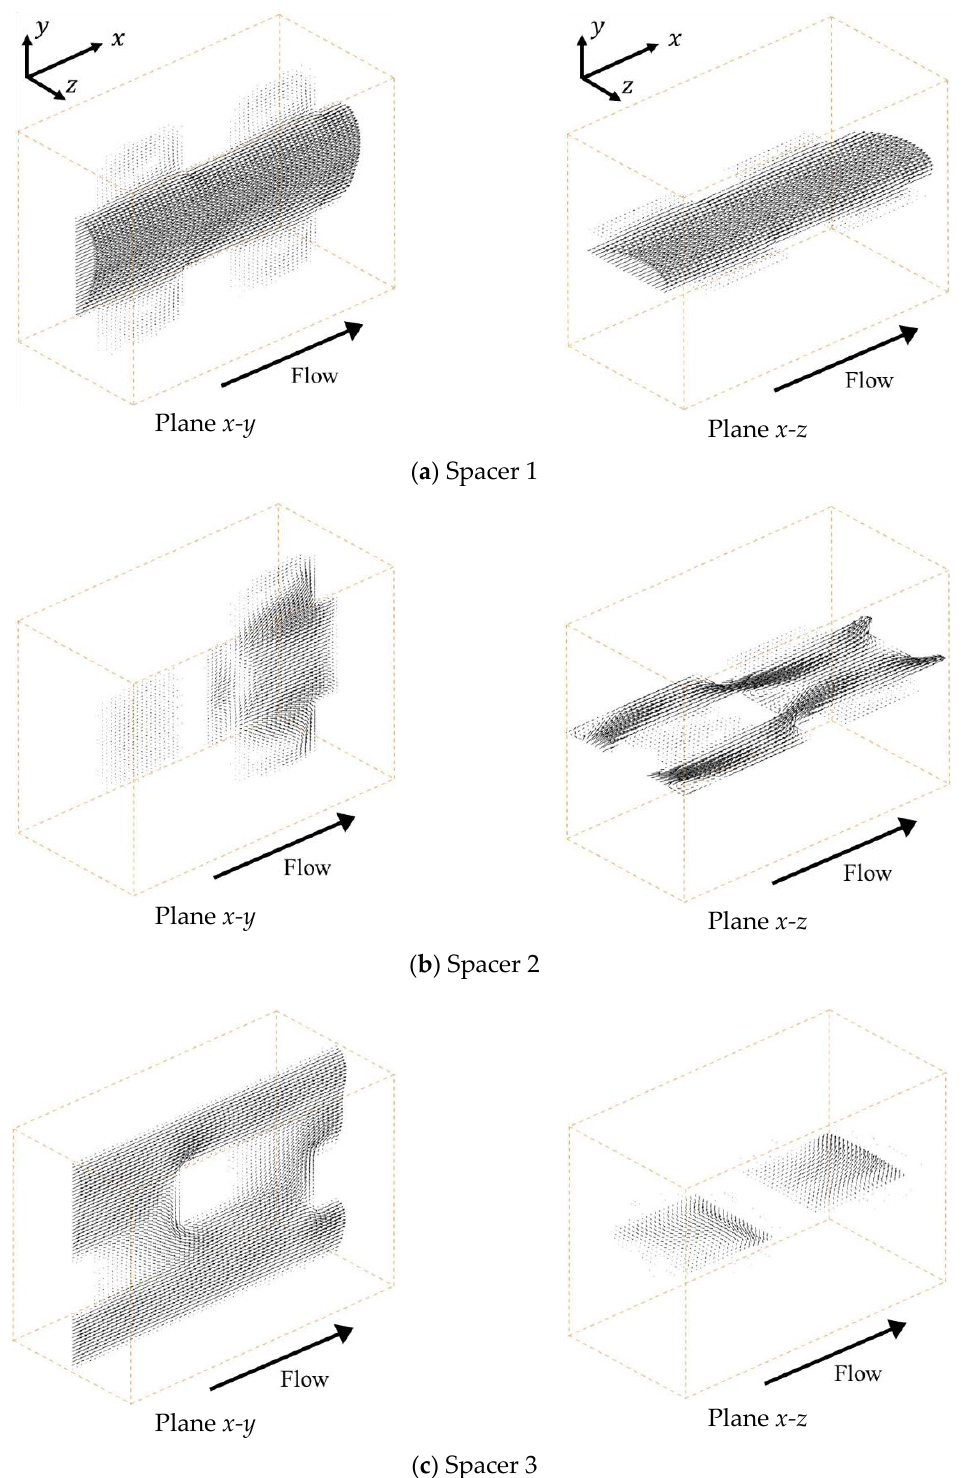
Figure 3. Velocity fields with porous spacers. ( a ) The flow is mainly linearly at the center part of the spacer and is shaped similar to a parabolic stream; ( b ) The flow is repeatedly separated and mixed in parallel to the ion exchange membranes due to the existence of Spacer 2; ( c ) The flow is repeatedly separated and mixed in the direction relative to the ion exchange membrane due to the existence of Spacer 3.